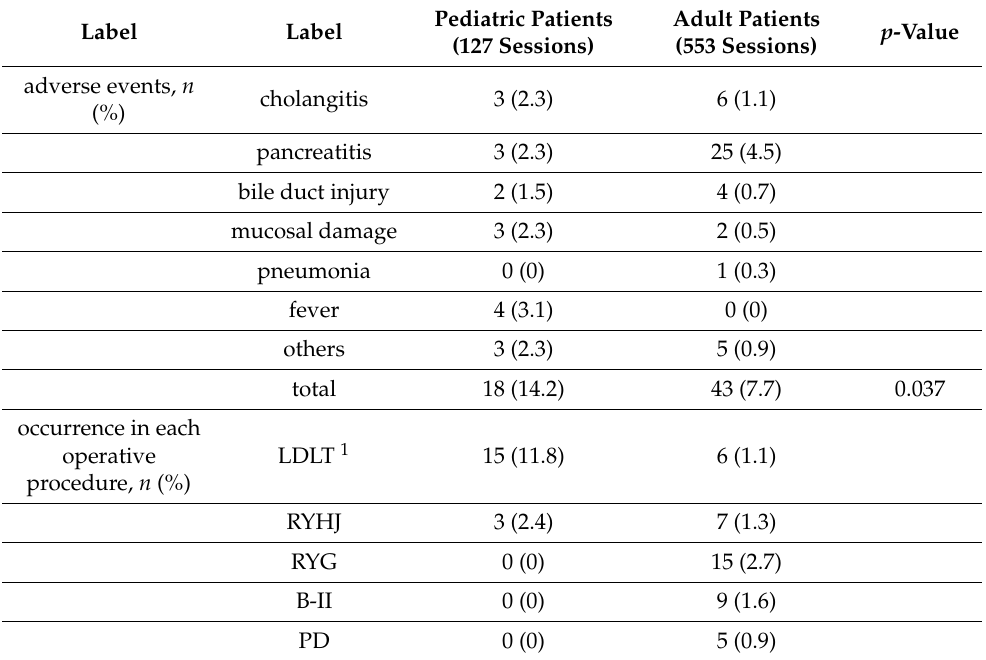
Table 5. Adverse events caused by balloon enteroscopy-assisted endoscopic retrograde cholangiogra-